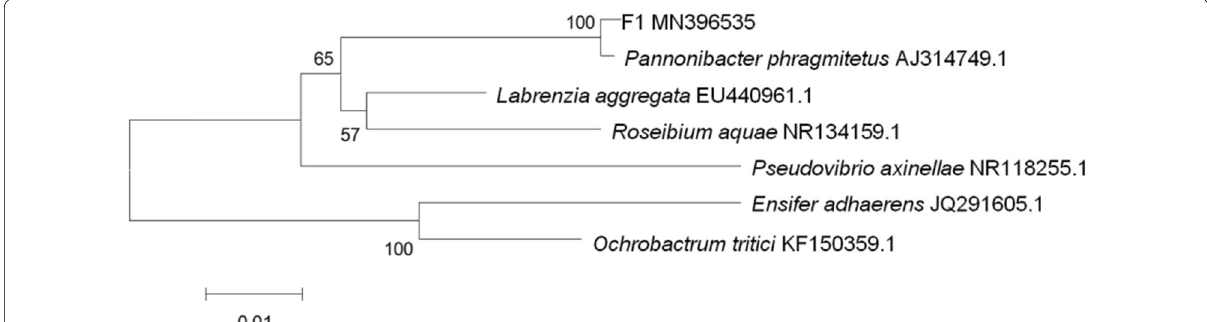
Fig. 2 Phylogenestraintic tree map of 16S rDNA gene sequence constructed by strain F1 and similar strains